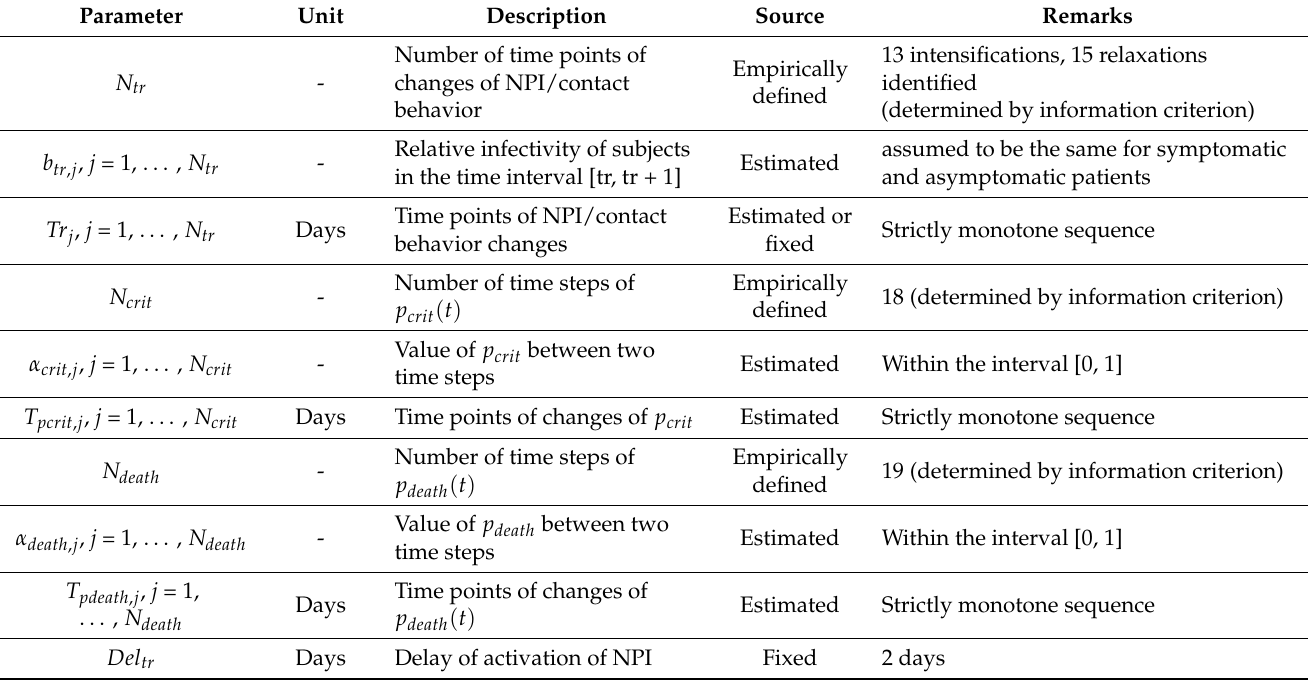
Table 3. Parameters used to define the input layer. These parameters were used to empirically model changing NPIs or changing contact behavior, changes in testing policies and changing age-structures during the course of the epidemic. Respective input functions constitute the input layer of our IO-NLDS